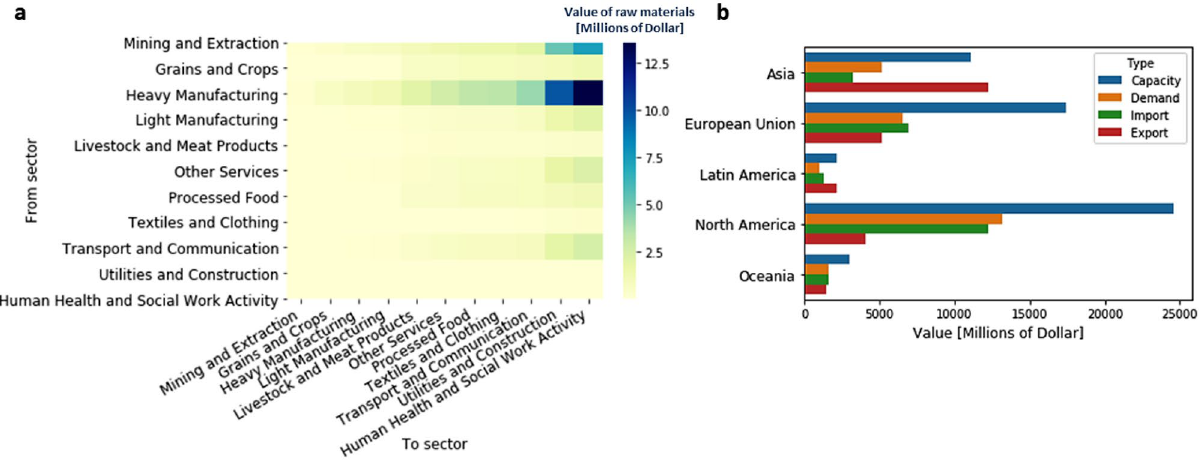
Figure 2. Global trade data analysis based on GTAP 10: (a) Values of required raw material from different sectors to satisfy the doubled production of each sector. The rows of the table define sectors that provide the raw materials, and the columns of the table define sectors that double their production. (b) Comparison of the production capacity, demands, and trade at the equilibrium between different regions. Here, the capacity is calculated by the total yearly production estimated from the total export and self-consumed resources. Demands are estimated based on the resource consumption from households and government. Trade history is based on resource exchanges in each region, including household, government, and